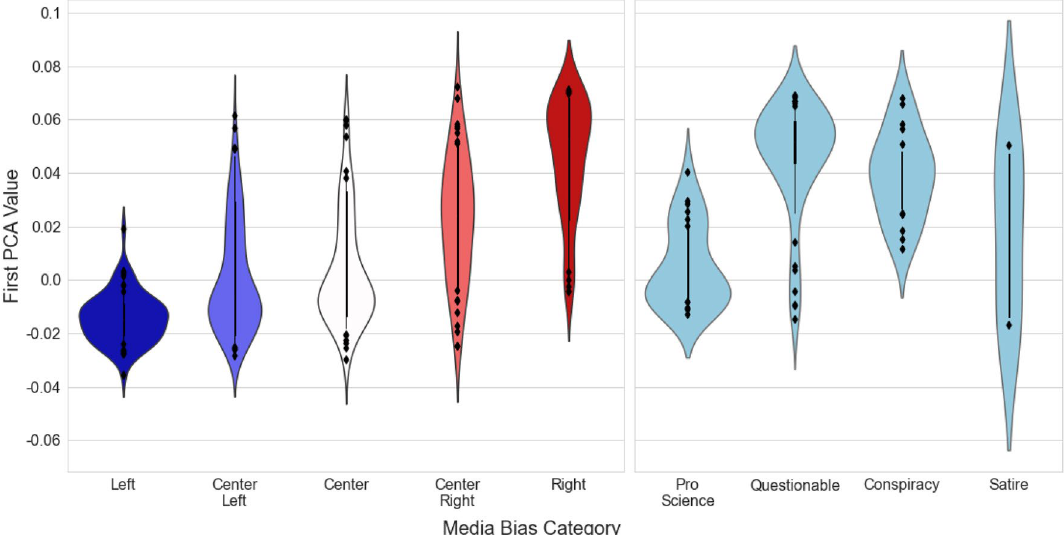
Figure 1. Distribution of linked domain first principal component entries by Media Bias Fact Chart (MBFC) categories 27 . 38% of linked domains from sentinel nodes were listed in MBFC as either Left, Center Left, Center, Center Right, or Right, and 9% were listed as either Pro Science, Questionable, Conspiracy, or Satire. Treating the political categories as an ordinal variable with ‘Left’ being equivalent to 1, ‘Center Left’ = 2, ‘Center’ = 3, ‘Center Right’ = 4, and ‘Right’ = 5, there is a correlation of 0.66 between the first PCA value and the political tilt of the domains